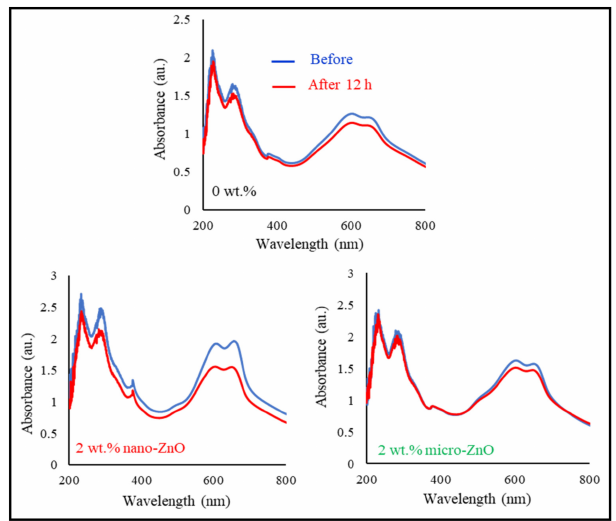
Figure 9. UV–vis spectra of the methyl blue-contaminated coatings with (2 wt.%) or without (0 wt.%) ZnO particles, before and after 12 h of UV